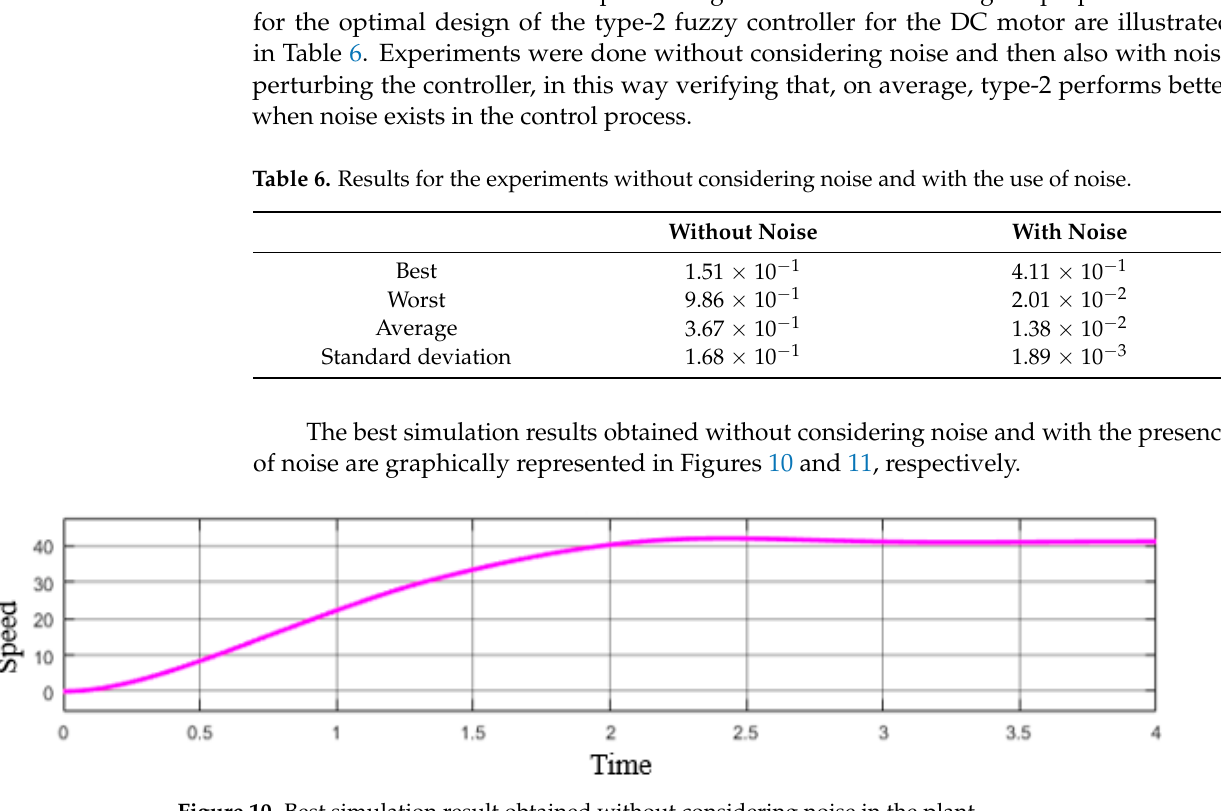
Figure 11. Best simulation result obtained with the presence of noise in the plant. Figure 12 illustrates the architecture of the fuzzy controller for the best simulation result obtained without considering noise applied in the control of the plant, and the sur- face is shown in Figure 13.